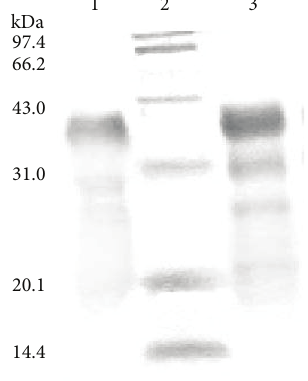
Figure 1: SDS-PAGE of GST-ZNF191(243-368) fusion protein. Lane 1: protein purified by G75, lane 2: protein marker, and lane 3: protein purified by affinity resin.